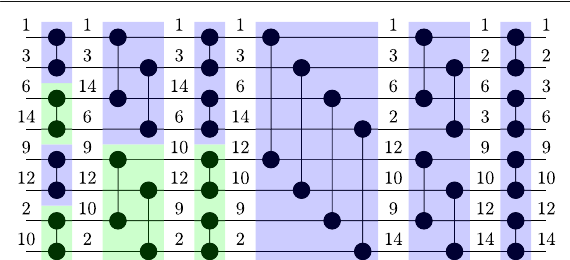
Fig. 3 Example of bitonic sort using eight numbers. Each horizontal wire corresponds to a core. The blue color denotes that the larger value will be stored at the lower wire after the comparison, while the green color the opposite